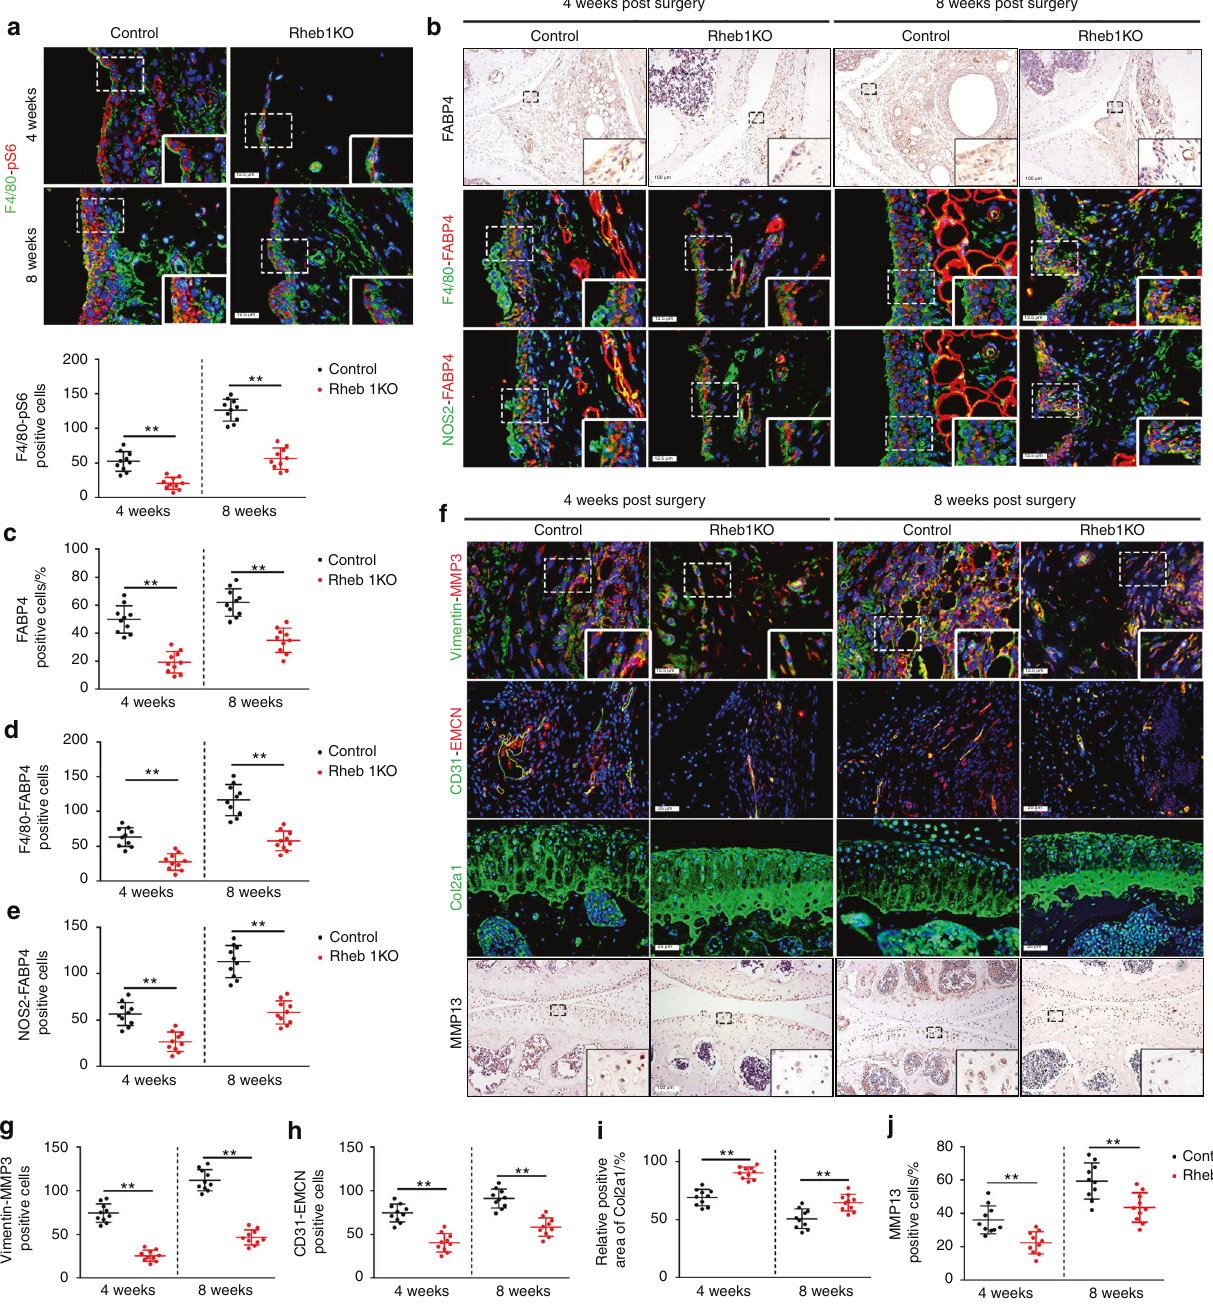
Fig. 5 Inhibition of the mTORC1 pathway reduces FABP4 secretion by M1-polarized macrophages to attenuate RA progression. a Representative images and quanti fi cation of F4/80 and pS6 coimmunostaining in the synovium of controls and Rheb1KO mice at 4 and 8 weeks after AIA modeling ( n = 10 per group). Scale bar: 12.5 µm. b – e Representative images ( b ) and quantitative analysis of FABP4 immunohistochemical staining ( c ) and coimmunostaining of FABP4 with F4/80 ( d ) or NOS2 ( e ) in the synovium of controls and Rheb1KO mice at 4 and 8 weeks after AIA modeling ( n = 10 per group). Scale bars: 12.5 µm and 100 µm. f – j Representative images ( f ) and quantitative analysis of Vimentin and MMP3 coimmunostaining ( g ), CD31 and EMCN coimmunostaining ( h ), Col2a1 immuno fl uorescence staining ( i ), and MMP13 immunohistochemical staining ( j ) in the knee joints of controls and Rheb1KO mice at 4 and 8 weeks after AIA modeling ( n = 10 per group). Scale bar: 12.5 µm, 25 µm, and 100 µm. Student ’ s t -test. ** P < 0.01. The data are shown as the mean ± SEM macrophages induced with LPS or MHY1485, whereas rapamycin signi fi cantly reversed this increase in expression. The regulation of FABP4 by the mTORC1 pathway was also observed in hemangio- mas. 23 The abovementioned data showed that the upregulation of FABP4 secretion by M1-polarized macrophages was triggered by activation of the mTORC1 pathway. Bone Research (2022)